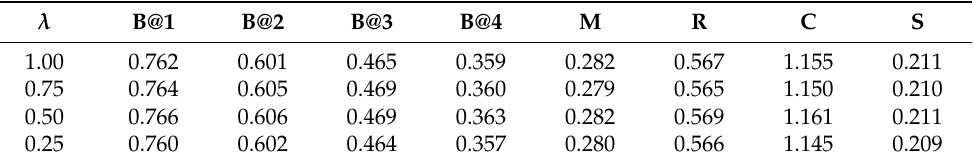
Table 4. The performance of DAT-PoS-Transformer with different values of hyperparameter λ on MSCOCO “Karpathy” test